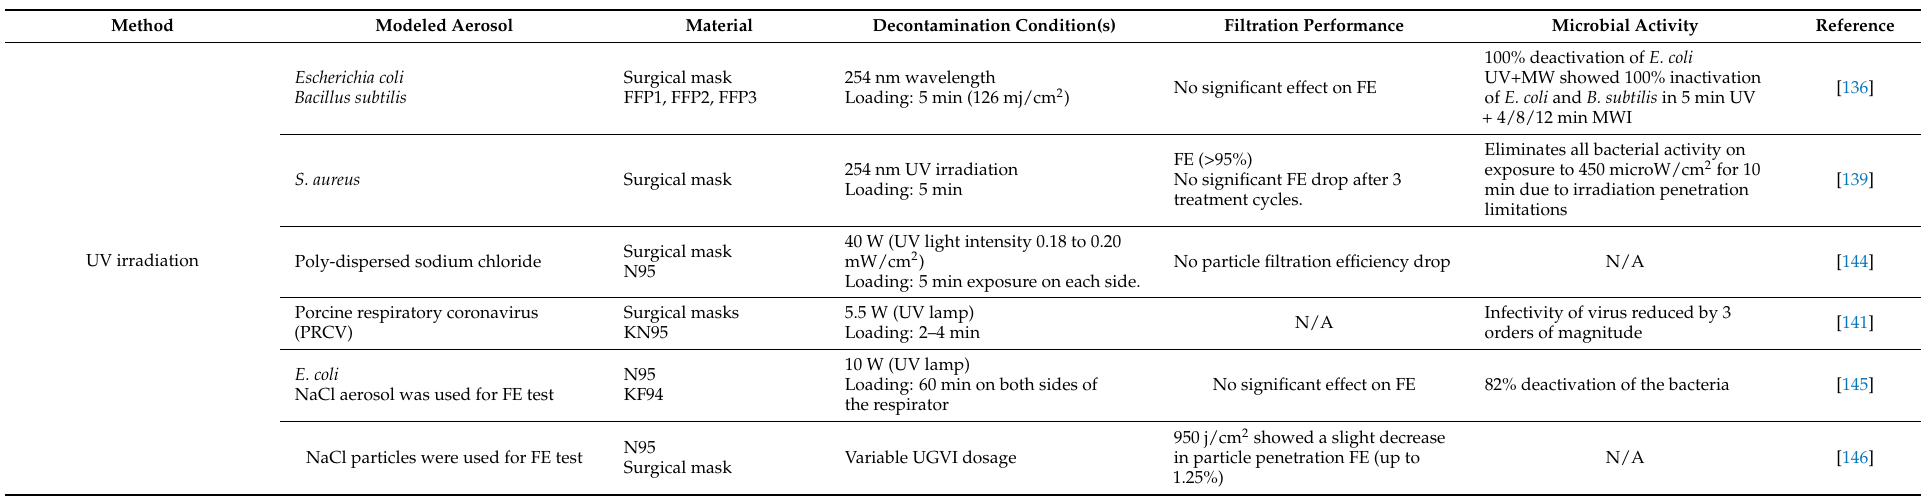
Table 12. Decontamination and regeneration using UV